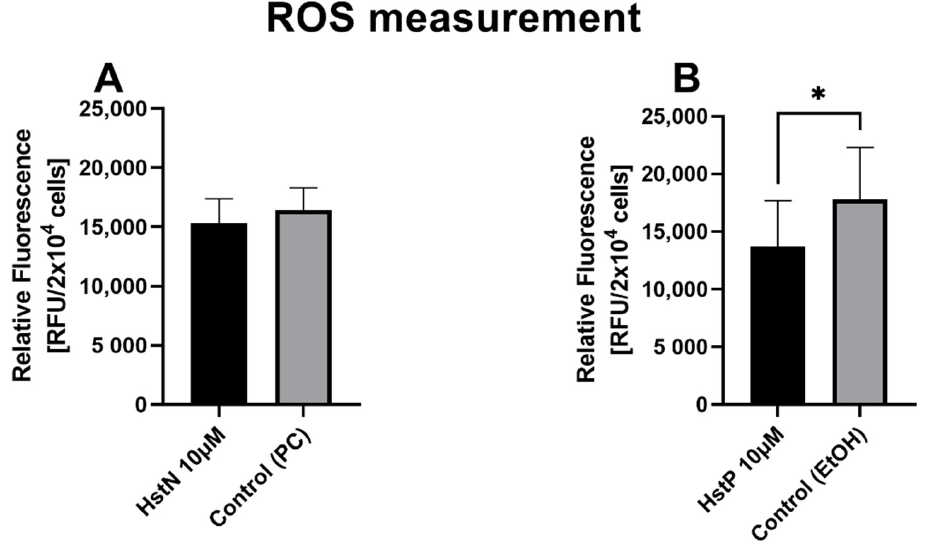
Figure 9. Effect of HstN and HstP on expression of ROS production in SH-SY5Y-APP 695 cells: ( A ) incubated for 24 h with HstN, with PC as control, and ( B ) incubated for 24 h with HstP, with ethanol as control. Respective mean values ± SD are shown, N = 10. Significance was determined with unpaired Student’s t-test. * p < 0.05. HstN, hesperetin nanocrystal; HstP, hesperetin in pure form; PC, PlantaCare; EtOH,